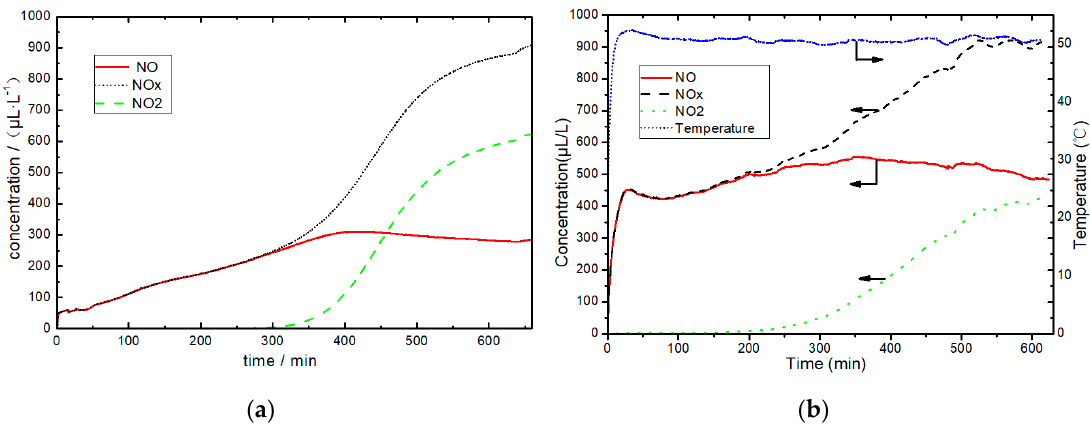
Figure 8. Effect of AC on NO + O 2 at low temperatures: ( a ) 15 °C; ( b ) 50 °C. Figure 8. E ff ect of AC on NO + O 2 at low temperatures: ( a ) 15 ◦ C; ( b ) 50 ◦